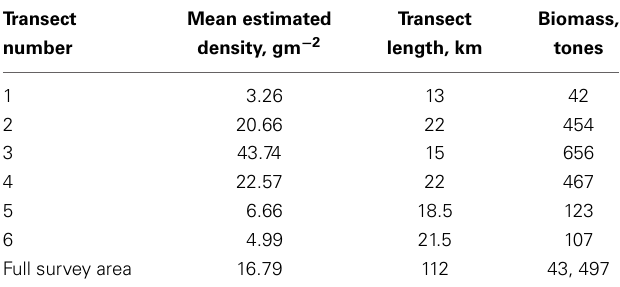
Table 2 | Estimated transect krill areal density and survey biomass for the six example